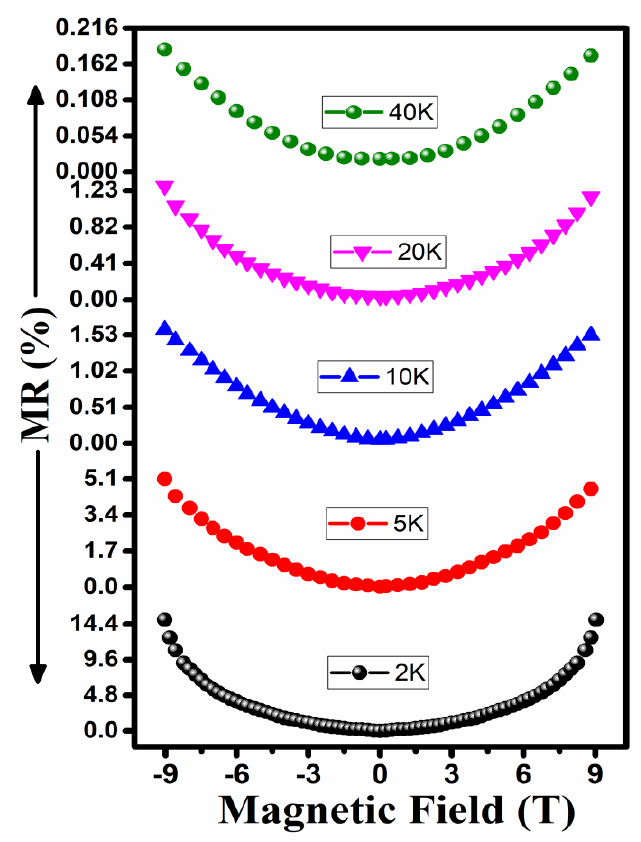
Figure 6. MR-B curves for temperature ranges from 2 K to 40 K.